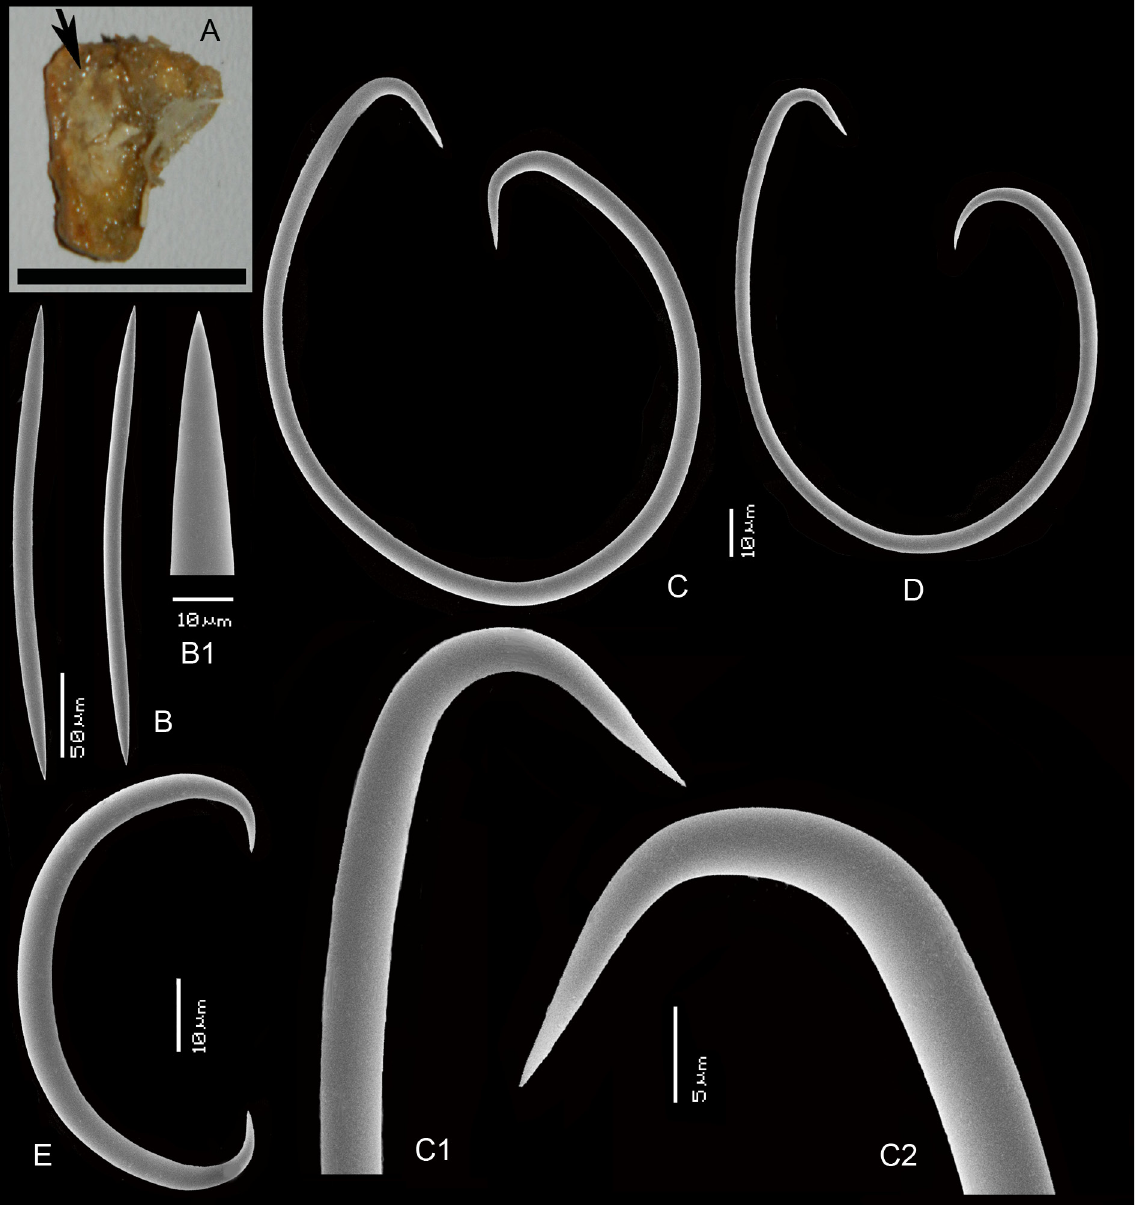
Fig. 13. Haliclona ( Flagellia ) porosa (Fristedt, 1887) subgen. et comb. nov., from Mauritania (ZMA Por. 06624). A . Habitus (arrow) on dead coral (scale bar = 1 cm). B–E . SEM images of the spicules. B . Oxeas. B . Detail of one of the apices. C–D . Flagellosigmas. C 1 C . Detail of short ending of flagellosigma. E . 2